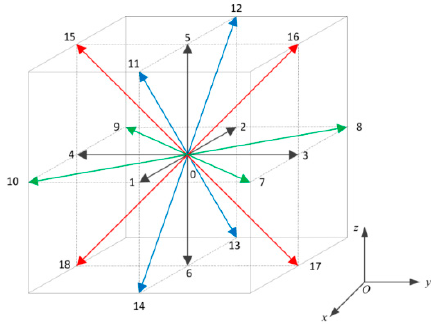
Table 2. Physical meanings of the symbols in the generalized transport equation. Equation